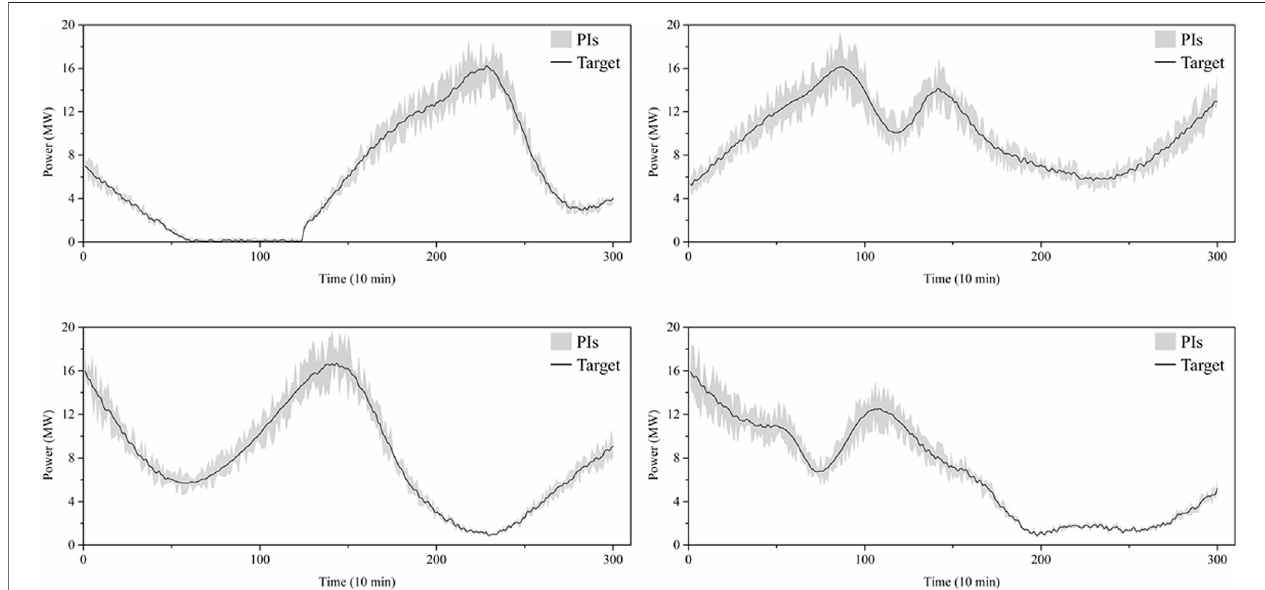
FIGURE 4 | Constructed PIs and actual target wind power of the test dataset.